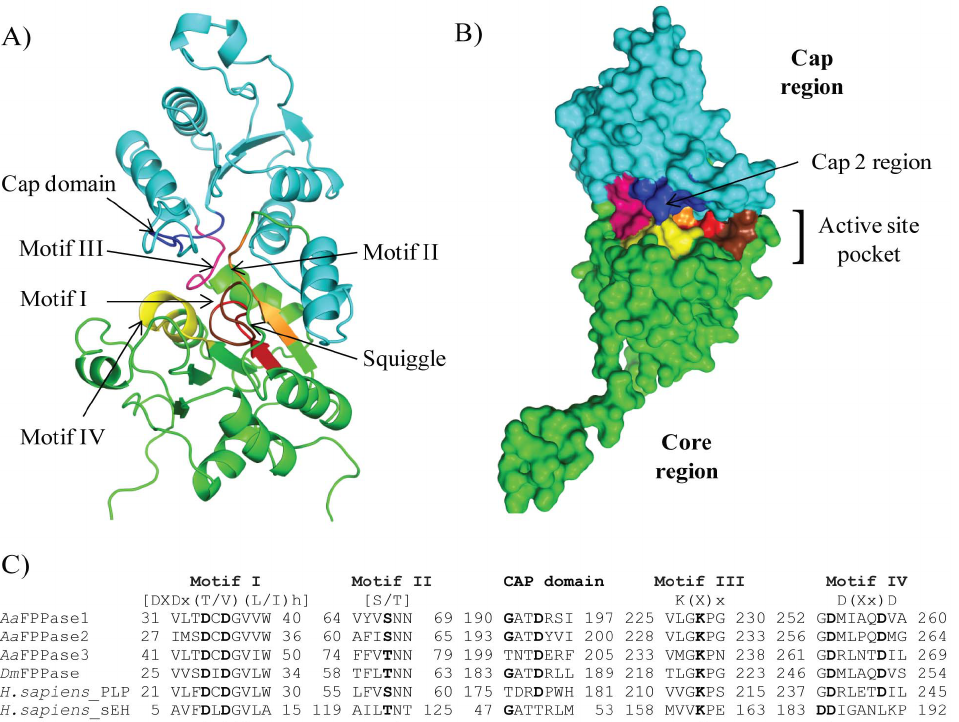
Figure 1. Homology model of the overall fold of Aa FPPase-1 and amino acid sequence alignment of HAD motifs and cap domains from mosquito, fruit fly and human. (A) Homology model of the overall fold of Aa FPPase-1. Core region is colored in green and cap region in light blue. Motifs are indicated by colors: motif I (red), motif II (orange), motif III (pink), motif IV (yellow), cap domain (dark blue) and squiggle (chocolate). B) Molecular surface diagram illustrating the active site pocket and the cap 2 region of Aa FPPase-1. Core region is colored green and cap region in light blue. Motifs are indicated by colors: Motif I (red), motif II (orange), motif III (pink), motif IV (yellow), cap domain (dark blue) and squigle (chocolate). The two structures were constructed by PyMOL using the Human pyridoxal phosphate phosphatase (2oycA) as template. C) Amino acid sequence alignment of HAD motifs and cap domains from mosquito ( Aa FPPase-1, -2 and -3), fruit fly ( Dm FPPase), human pyridoxal phosphatase ( H. sapiens _PLP) and human epoxy hydrolase ( H. sapiens _sEH). The suggested functions for the motifs are: motif I is required for nucleophilic attack, motif II is responsible for substrate binding, the motif III Lys is required for stabilizing the negative charge of the reaction intermediate together with the Ser/Thr of motif II, motif IV is needed for Mg 2 + ion binding and the cap domain is involved in substrate recognition. Bold letters indicate the conserved residues in each motif. The numbers represent the amino acid positions in the sequences. ‘‘h’’ denotes a hydrophobic residue and ‘‘x’’ any residue. Accession numbers: Dm FPPase (CG15739), H. sapiens _PLP (NP_064711.1) and H. sapiens _sEH (NP_001243411.1).